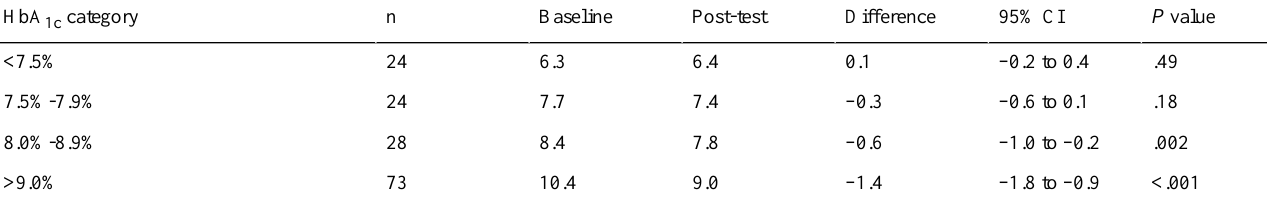
Table 3. Baseline to post-test changes in hemoglobin A 1c (HbA 1c ) based on starting HbA 1c